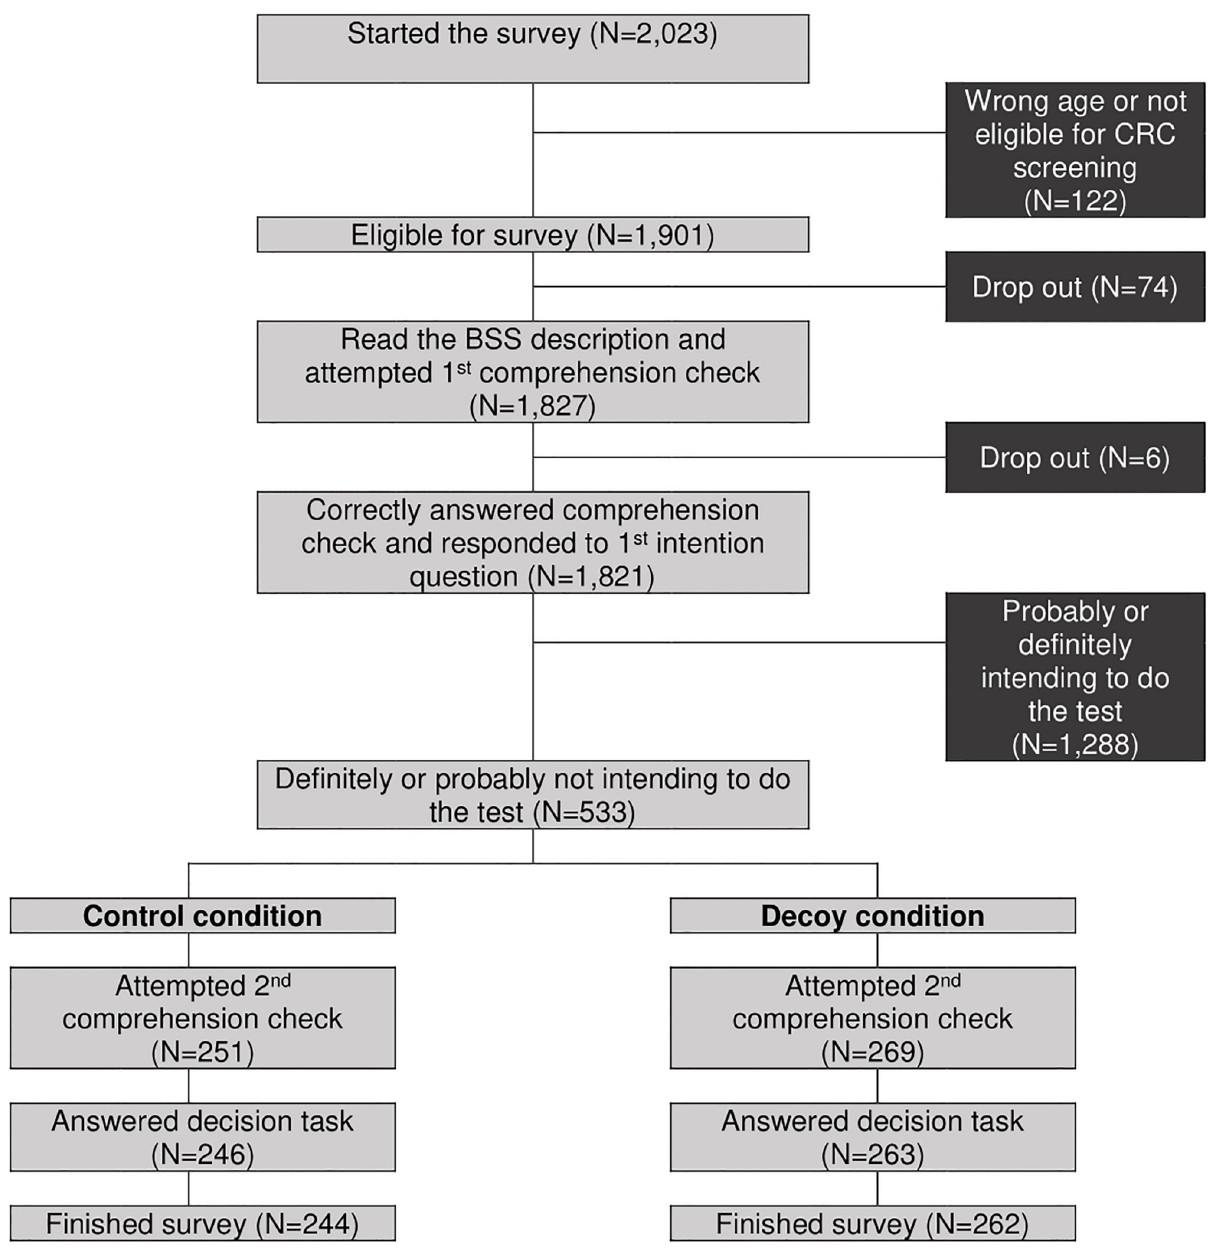
Fig 2. Flow though Study